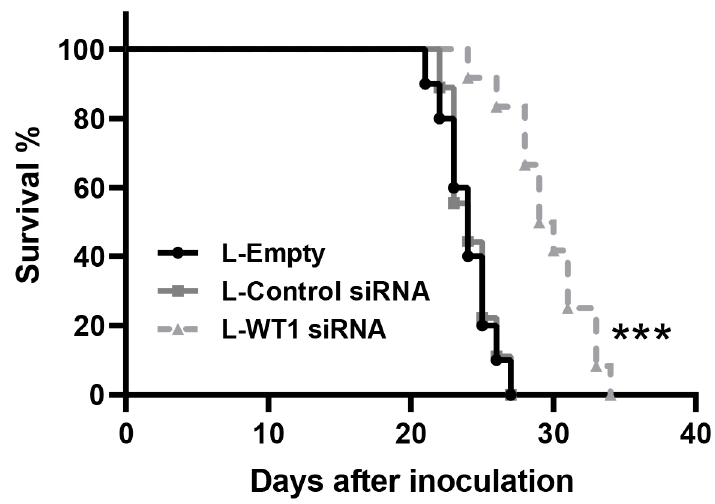
Figure 5. Survival assay for melanoma lung cancer metastasis model in mice treated with respiratory L-WT1 siRNA. Respiratory therapy of L-WT1 siRNA twice per week improved the survival rate of the treated animals. Log-rank test was performed as a statistical analysis. *** p < 0.001.